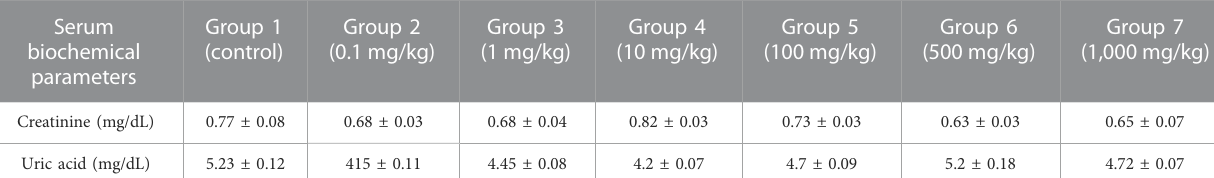
TABLE 9 Subacute toxicity study on biomarkers of kidney malfunction in mice.